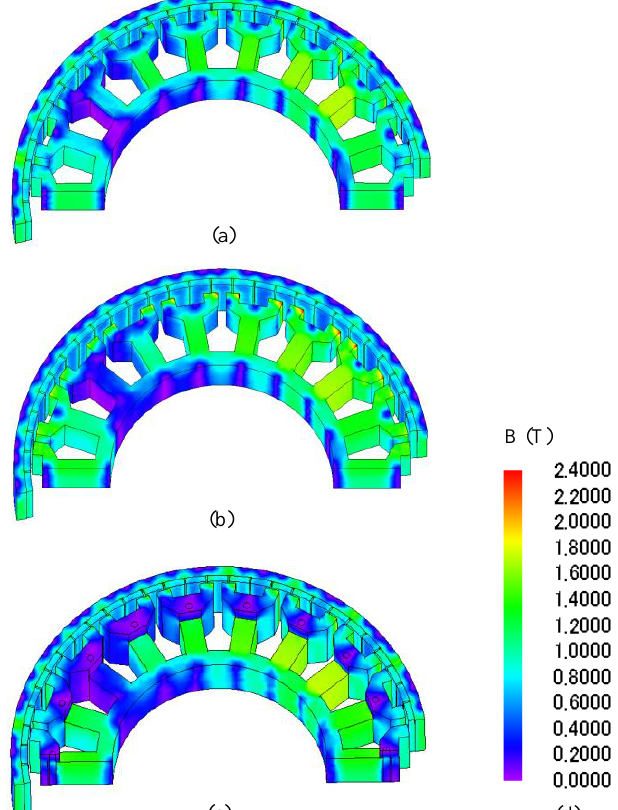
Figure 7. Flux density distributions of the three machines at rated load condition. ( a ) M I. ( b ) M II. ( c ) M III. ( d ) Scale bar.